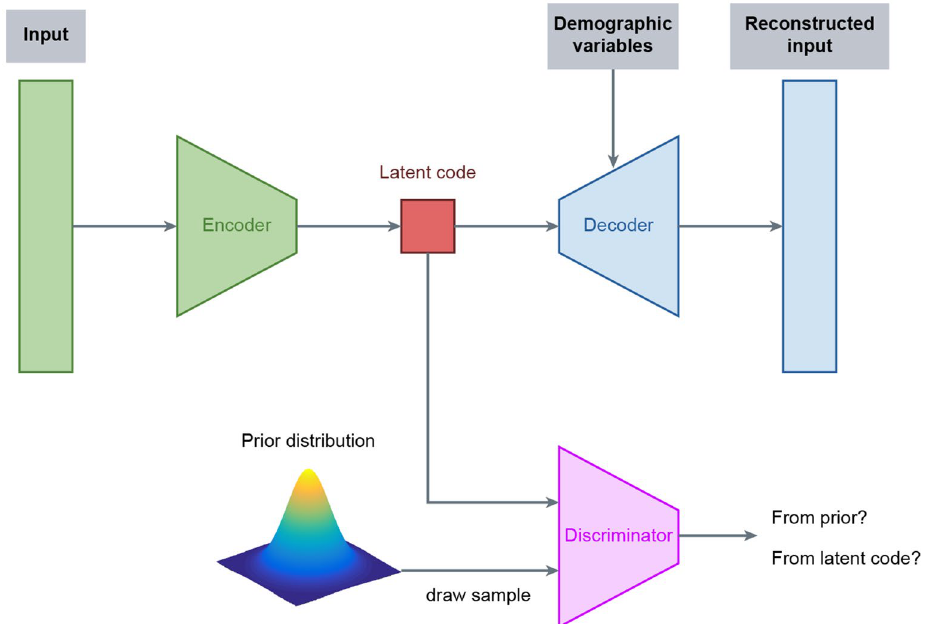
Figure 1. Structure of the normative model based on adversarial autoencoders. In this configuration, the subject data is inputted into the encoder and then mapped to the latent code. This latent code is fed to the decoder with the demographic data, and then the decoder generates a reconstruction of the original data. During the training of the model, the discriminator predicts if its input data came from the latent code or if it was randomly sampled from the chosen prior distribution (e.g. Gaussian distribution). Based on these predictions, the adversarial autoencoder forces the encoder to produce a latent code similar to the prior distribution selected. Since the model is trained on healthy controls data, it is expected that it can reconstruct similar data relatively well, yielding a small reconstruction error. However, the model is expected to generate a high error when processing data affected by unseen underlying mechanisms, e.g. pathological